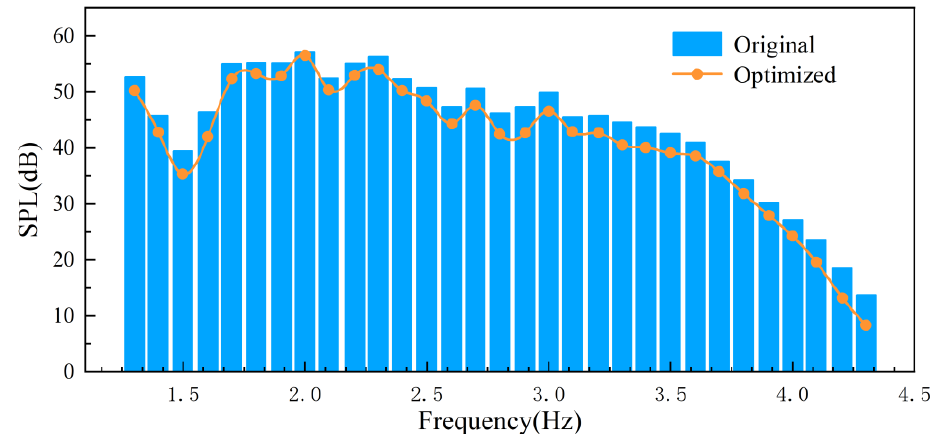
Figure 24. Comparison chart of 1/3 times frequency before and after guide vanes optimization.